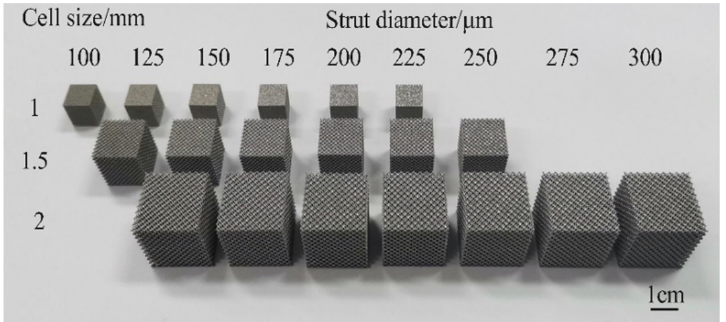
Figure 6. SLM porous Ti6Al4V alloy compression specimens.